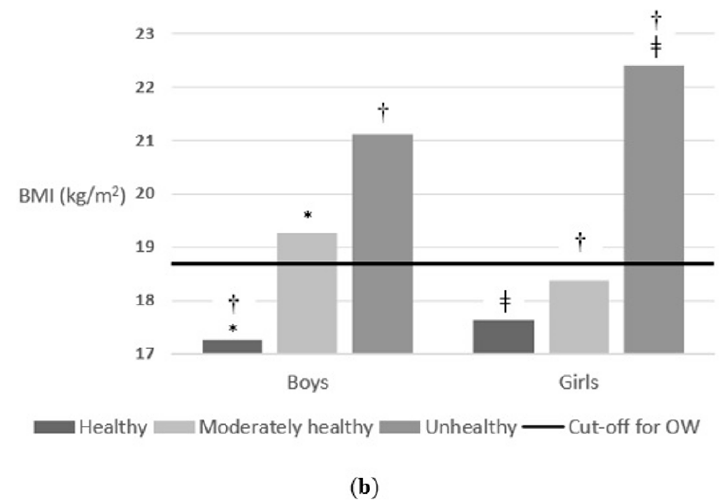
Figure 5. ( a ) Association between the combined score of lifestyle behaviours and self-reported physical fitness on body weight status; ( b ) Association between the combined score of lifestyle behaviours and self-reported physical fitness on body weight status segmenting by sex. The cut-off for OW line indicates the beginning of the OW category according to Cole’s cut-off points [44]. * p -value < 0.001, ** p -value < 0.001, ‡ p -value < 0.01 and † p -value < 0.05. Abbreviations: LB, lifestyle behaviours; SRPF, self ‐ reported physical fitness.